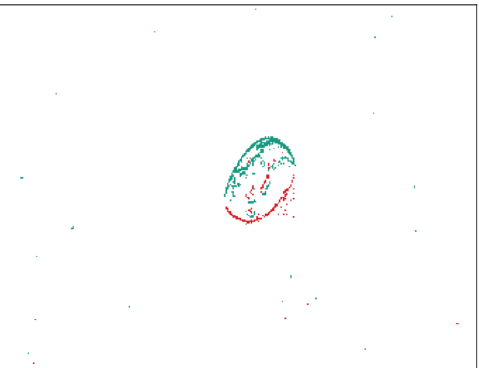
Figure 8. Example of an unprocessed recording of a Borlotti bean on a conveyor belt (animated in the digital version of this